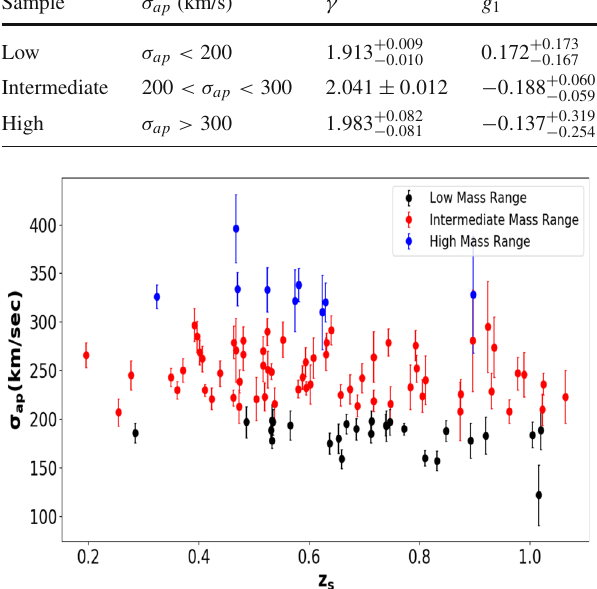
Fig. 2 ThedifferentredshiftsrangecoveredbyLow,Intermediate,and